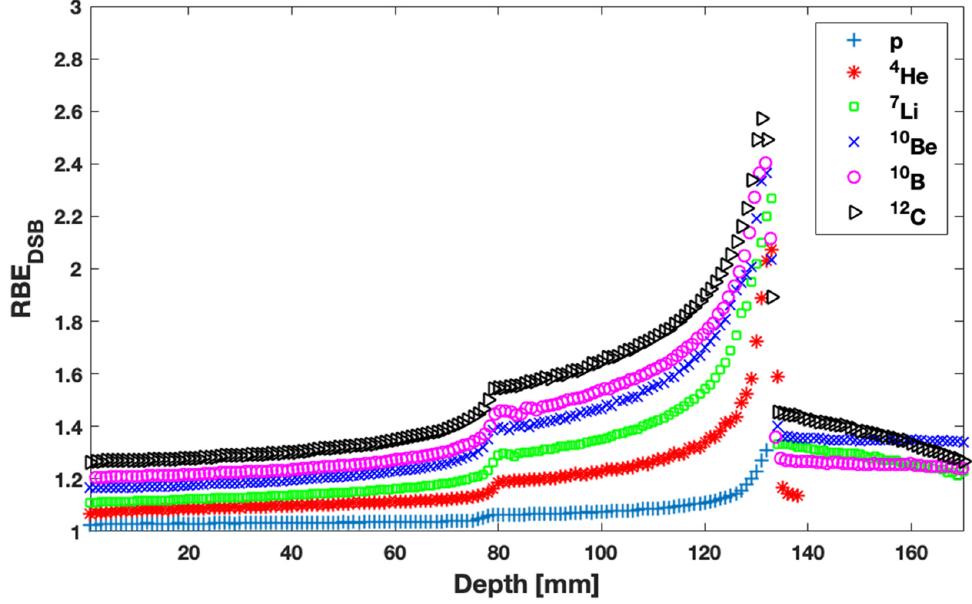
Figure 4. RBE DSB values of p, 4 He, 7 Li, 10 Be, 10 B, and 12 C as a function of depth for a well- Figure 4. 𝑅𝐵𝐸 (cid:3005)(cid:3020)(cid:3003) values of p, 4 He, 7 Li, 10 Be, 10 B, and 12 C as a function of depth for a well ‐ oxygen ‐ Figure 4. 𝑅𝐵𝐸 (cid:3005)(cid:3020)(cid:3003) values of p, 4 He, 7 Li, 10 Be, 10 B, and 12 C as a function of depth for a well ‐ oxygen ‐ ated target. oxygenated ated target.